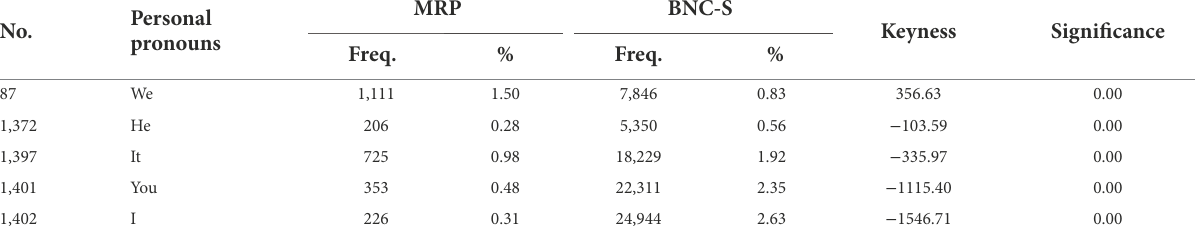
TABLE 9 Key personal pronouns in MRP (in comparison with BNC-S).